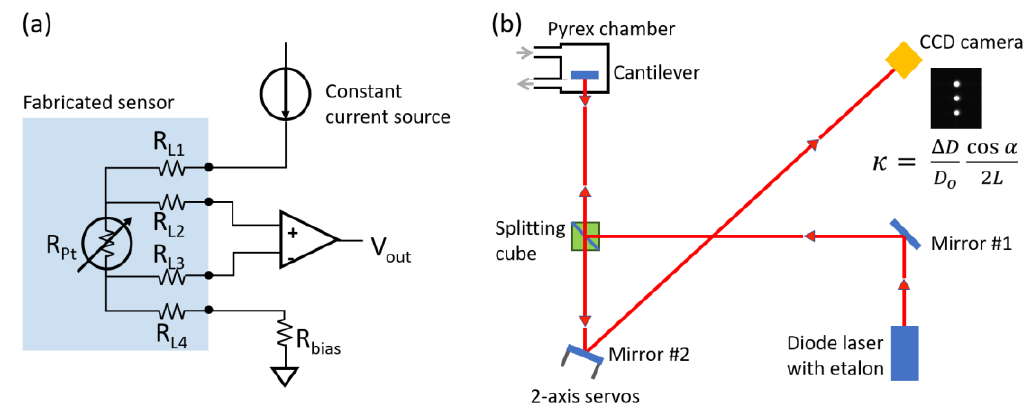
Figure 3. Schematics of ( a ) Four-wire temperature measurement circuit with Kelvin connection and ( b ) in situ cantilever curvature measurement system comprised of a multi-beam optical stress sensor. A typical CCD image is shown. The curvature of the cantilever is determined by the average spot separation.